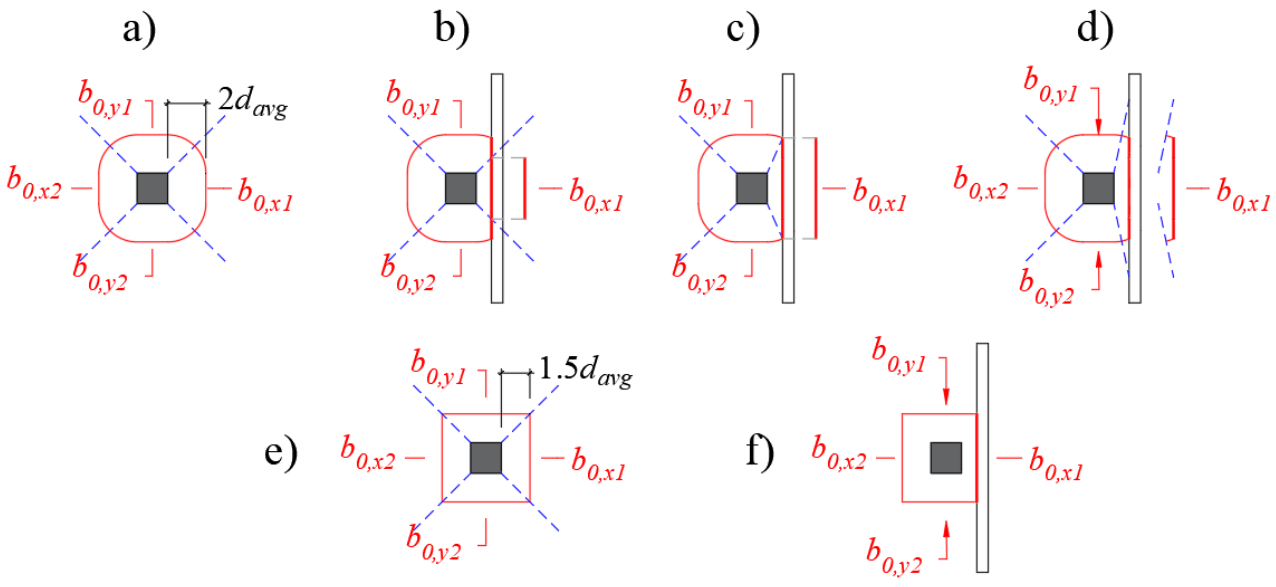
Figure 14. Possible partitions of the shear-resisting control perimeter for simply supported slabs and EN 1992-1-1:2004: ( a – d ) using the rounded corners; ( e ) and ( f ) using the squared control